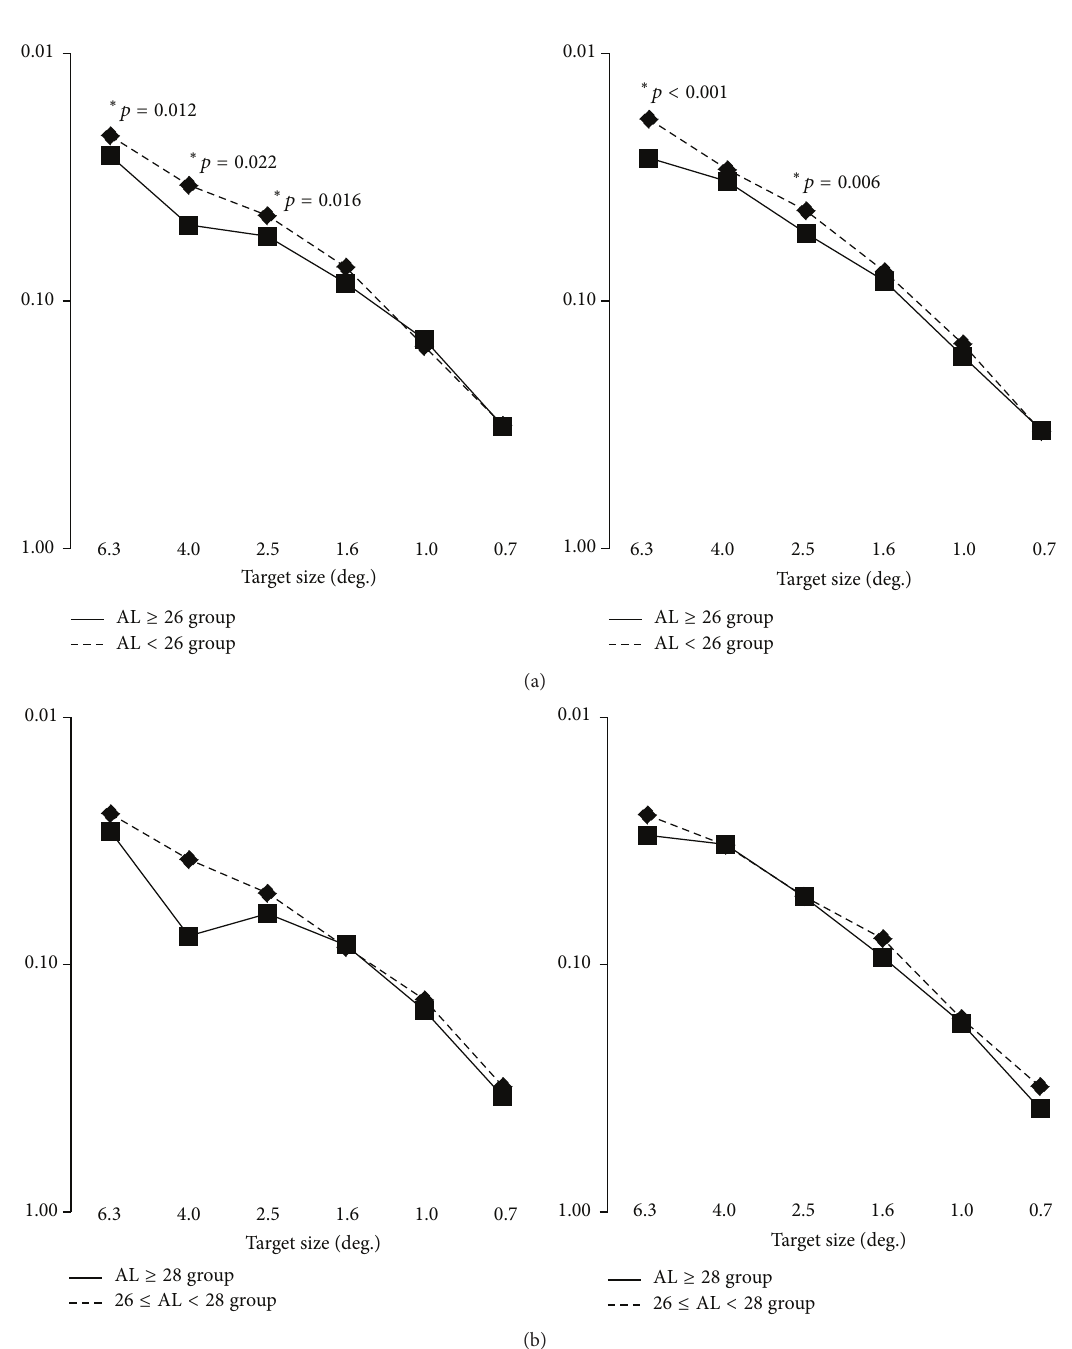
Figure 7: Contrast sensitivity at various target sizes. (a) Eyes were divided into axial length of 26 mm or longer (AL ≥ 26 group) and less than 26 mm (AL < 26 group). In the absence of glare, significant differences in contrast sensitivity are observed between two groups at target sizes of 6.3 ∘ , 4.0 ∘ , and 2.5 ∘ . In the presence of glare, significant differences are observed between two groups at target sizes of 6.3 ∘ and 2.5 ∘ . (b) Eyes in AL ≥ 26 group were further divided into 26 ≤ AL < 28 group and AL ≥ 28 group. No significant differences are observed. ∗ Mann-Whitney 𝑈